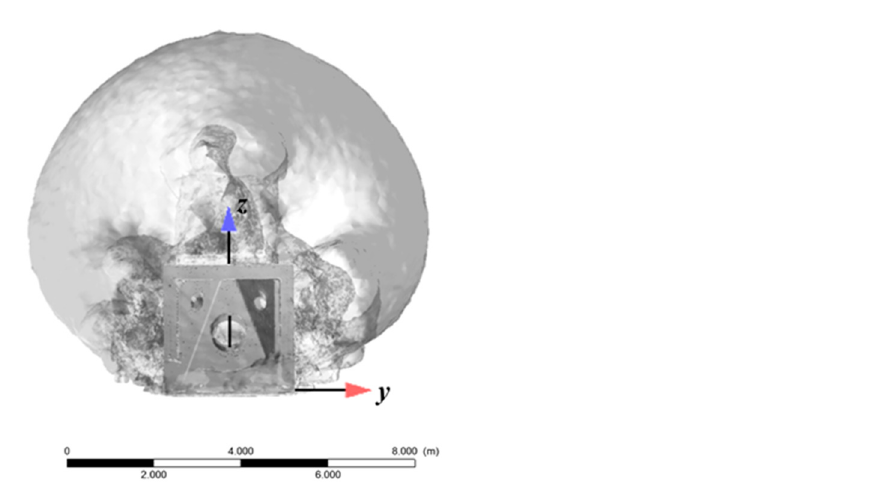
Figure 9. Transverse influence range of upwelling of the upwelling reef ( y - z plane).